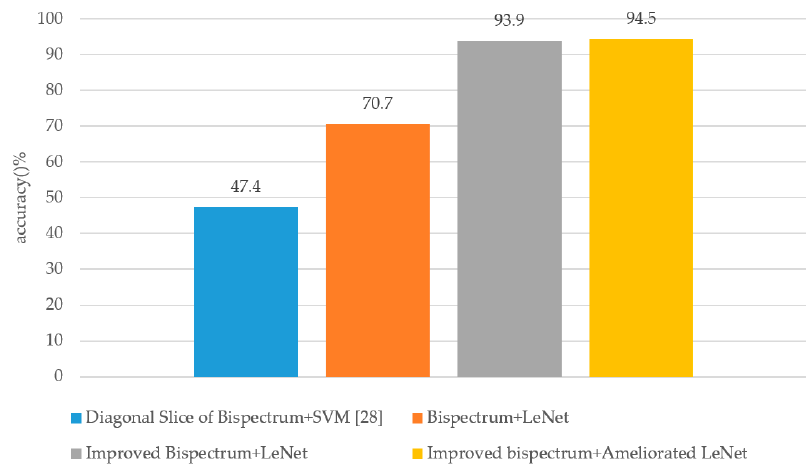
Figure 20. The recognition accuracy of different algorithms. Bispectrum: the magnitude information of bispectral estimation, which is used widely in traditional signal recognition. Improved bispectrum: the magnitude information and the phase information of the bispectral estimation utilized together. LeNet: the original LeNet.